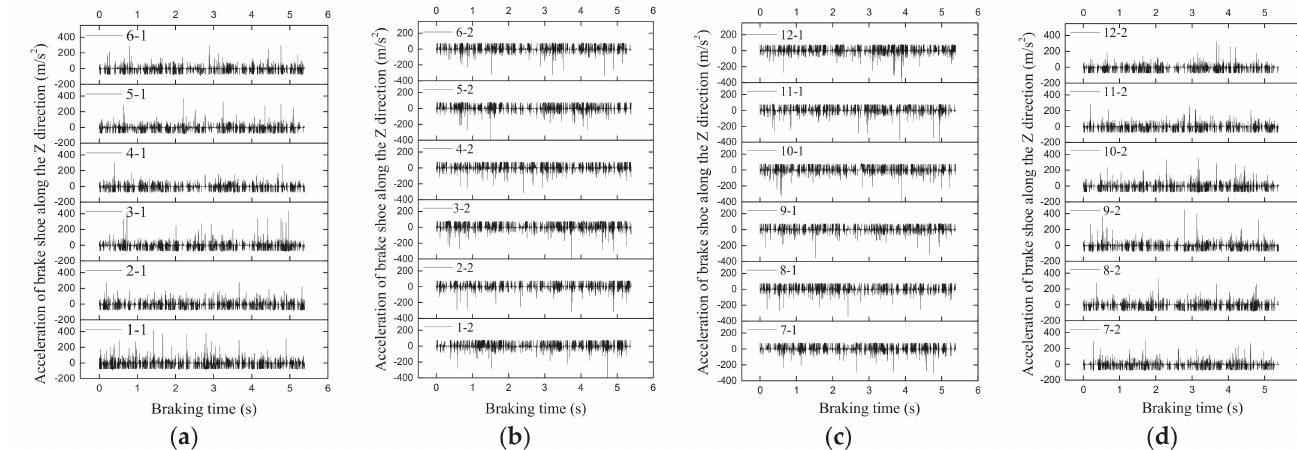
Figure 6. Evolution curves of accelerations in the Z direction of brake shoes 1-12. ( a ) Brake shoes 1-1 to 6-1 ( b ) brake shoes